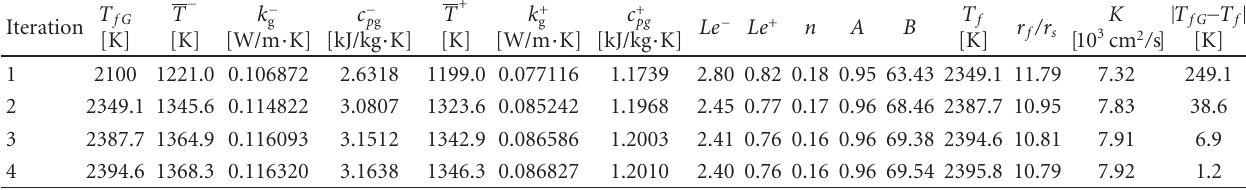
Table 3: Proposed model n -hexane results.